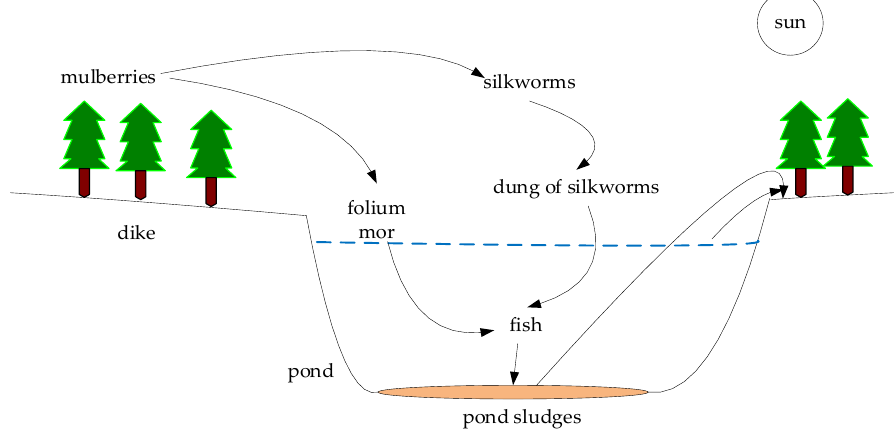
Figure 2. The traditional dike–pond system (the mulberry dike–fishpond system). Existing research on the identification of the land-use modes of the dike–pond systems has primarily focused on two aspects. The first aspect is the classification of the dike– pond utilization forms with respect to dike–pond utilization and transformation. For example, Sinha et al. used hydrogeomorphology to classify the land use to represent the characteristics of the dike–pond system indirectly [26]. Min et al. classified the dike– pond system as a subtype of the integrated farming systems in wetland ecosystems [27]. Liu classified the land use of the dike–pond systems in Nanhai using grading and a continu- ous classification method [28]. The second aspect is the identification of the land-use modes of the dike–pond systems based on analyzing the internal components of the sys- tem and their interaction. For example, Edwards identified the dike–pond systems of In- donesia, Philippines, Malawi, Thailand, and China as crop–livestock–fish integrated farming systems based on the interactions of the components in subsystems [25]. Zhong categorized the types of dike–pond systems in the Pearl River Delta based on differences in the composition and transformation of natural resources [29]. Luo identified the mul- berry dike–fishpond systems in the Pearl River Delta as complex modes based on biolog- ical organization hierarchy [30]. These studies revealed that dike–pond systems have the characteristics of natural factors. However, dike–pond systems are complex and artificial